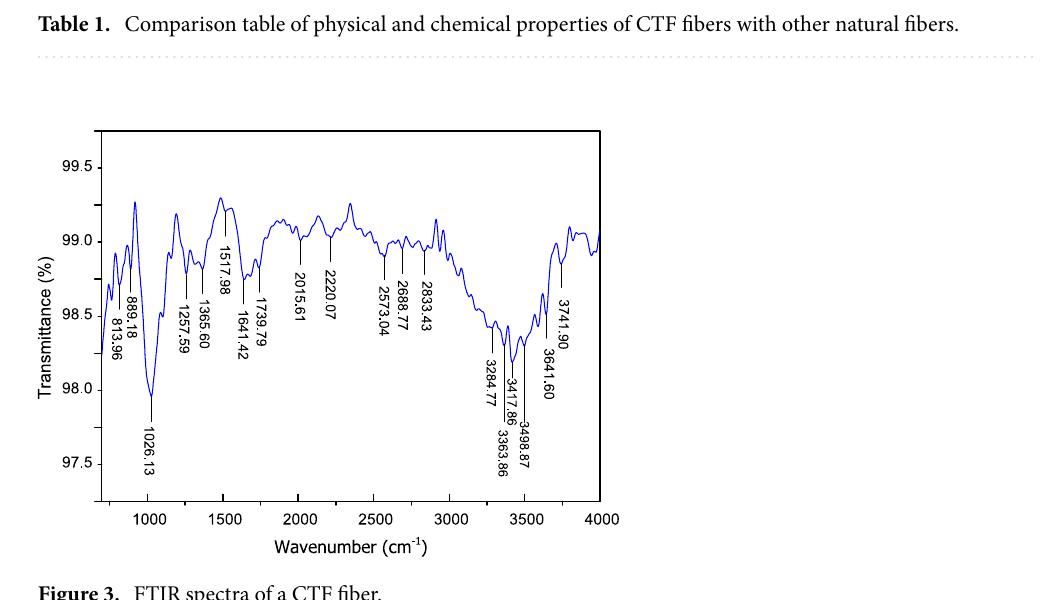
Figure 3. FTIR spectra of a CTF